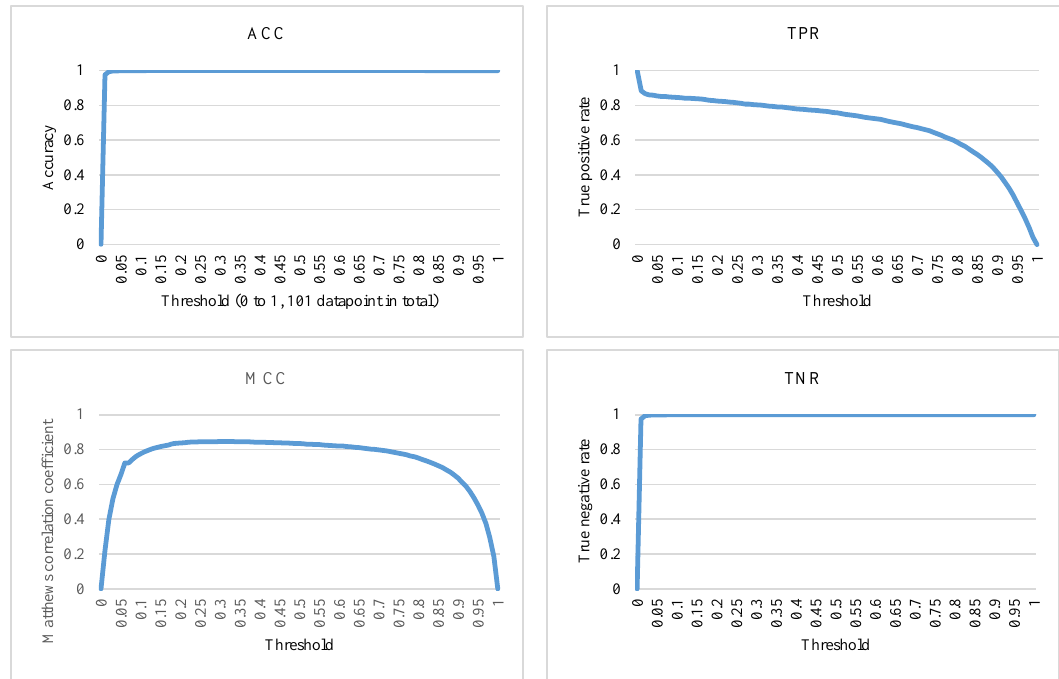
Figure 6. The ACC, TPR, TNR, and MCC of AE-PRF for different threshold values.